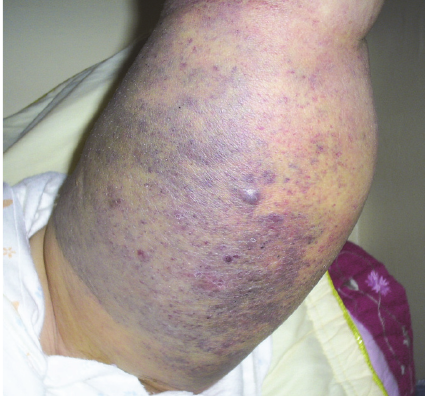
Figure 2: Appearance of the indurated nodule at the posterior surface of the upper limb of the left arm.